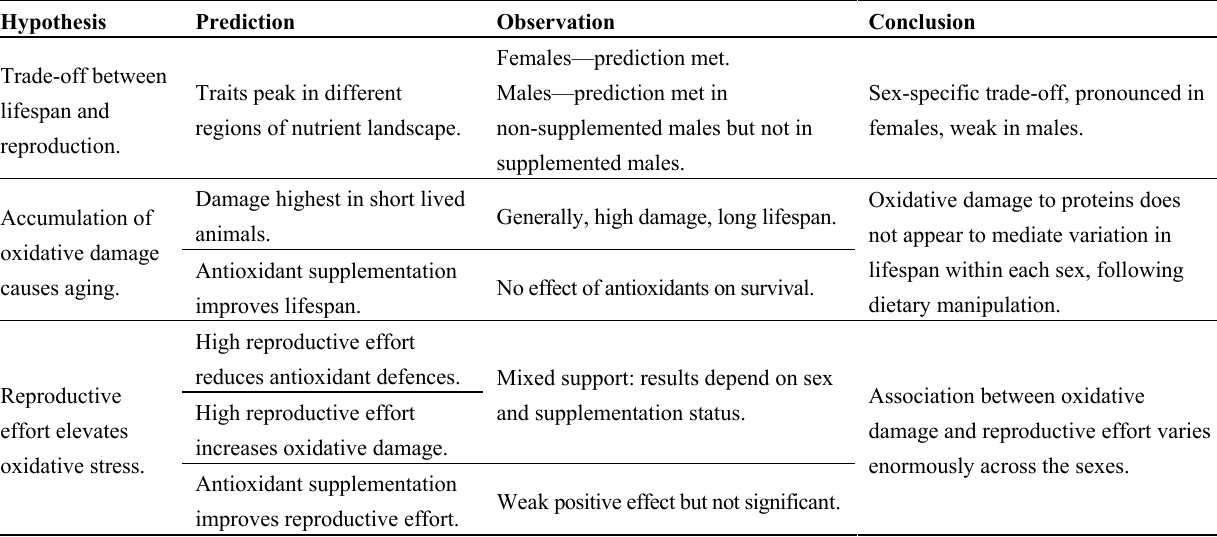
Table 3. A summary of the main conclusions drawn by this